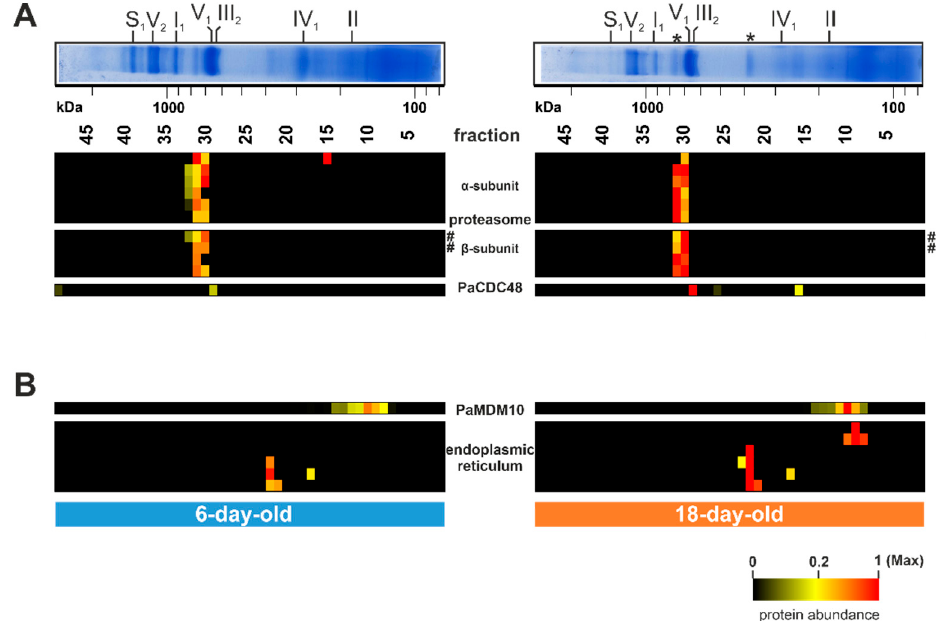
Figure 6. Age ‐ dependent increase of non ‐ mitochondrial complexes. ( A ) Quantified proteins of the proteasome and PaCDC48 (Pa_7_5590) are represented in a heat map. ( B ) Selected quantified proteins of the endoplasmic reticulum and PaMDM10 (Pa_7_11600) are represented in a heat map. The color scale ranges from black (not identified), to yellow (20% of the maximum), to red (maximum abundance). Asterisks (*) mark hitherto uncharacterized protein bands. Hashtags (#) mark two catalytic subunits (PaPRE3 and PaPRE2) of the proteasome β‐ subunits. For detailed information about the corresponding proteins refer to Table S1F.